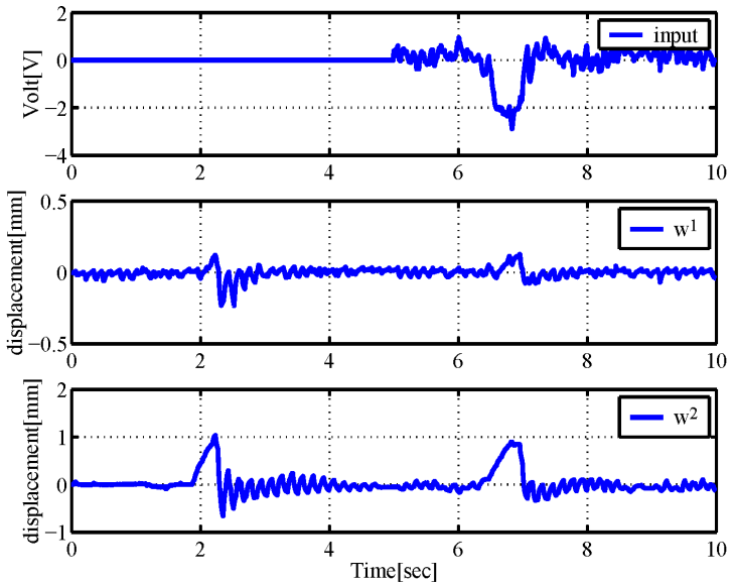
Figure 6. Experimental Results for